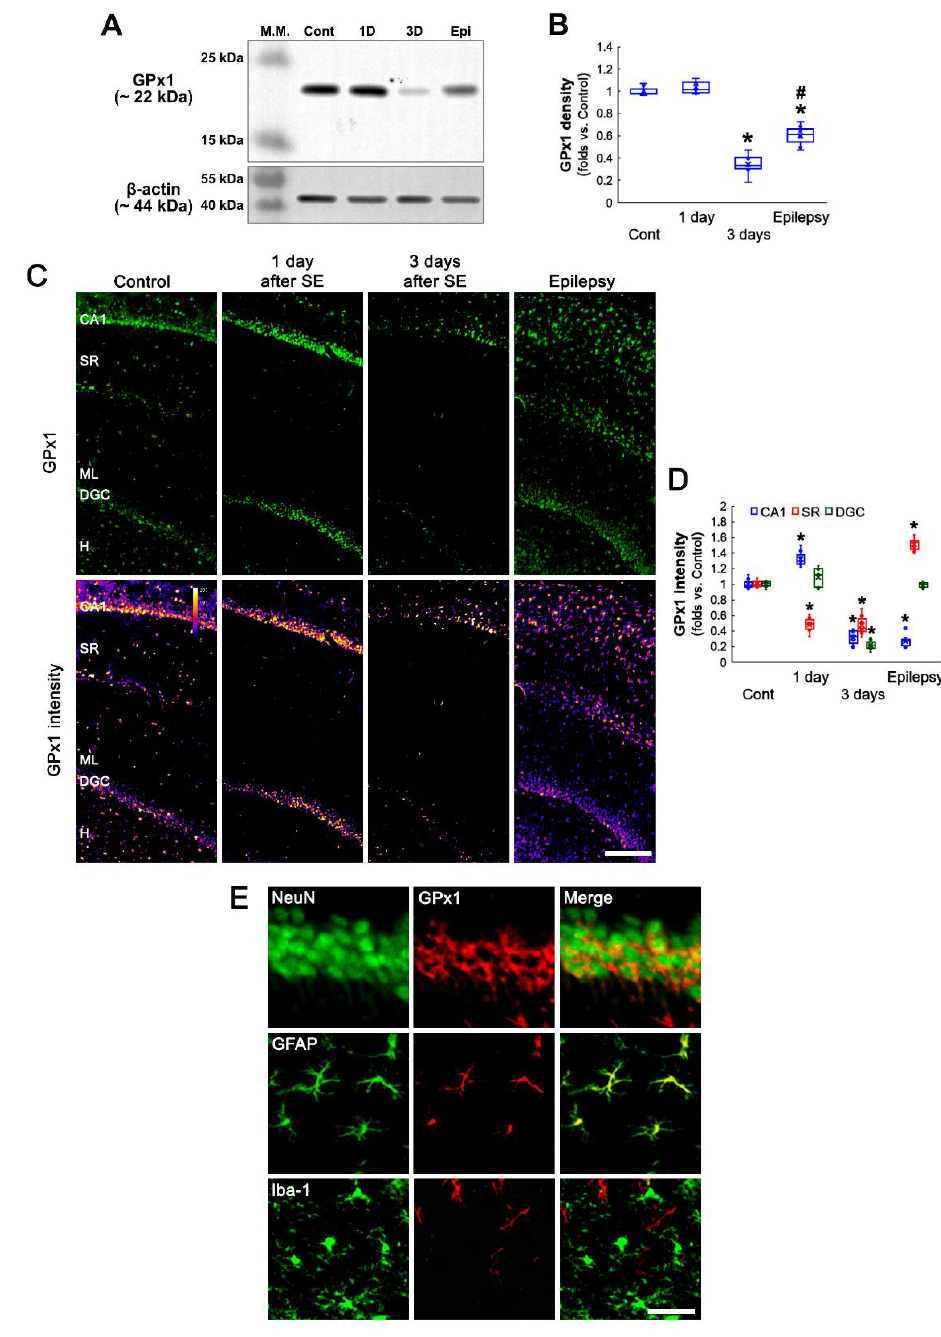
Figure 1. Effects of SE on GPx1 expression in the rat hippocampus. GPx1 expression is mainly observed in neurons (NeuN, a neuronal marker) and astrocytes (GFAP, an astroglial marker), but not microglia (Iba-1, a microglial marker), under physiological conditions. Following SE, GPx1 expression shows the temporal and spatial alterations in the hippocampus. ( A ) Representative Western blot of GPx1 in the whole hippocampus. ( B ) Quantification of GPx1 protein level based on Western blot data (*, # p < 0.05 vs. control and 3 day-post SE animals, n = 7, respectively). ( C ) Representative photos of GPx1 expression and its intensity. Bar = 250 μm. ( D ) Quantification of GPx1 intensity in CA1 neurons (CA1), the stratum radiatum (SR) and dentate granule cells (DGC) (* p < 0.05 vs. control animals, n = 7, respectively). ( E ) Cellular localization of GPx1 in the hippocampus under physiological conditions . Bar = 25 (NeuN) and 12.5 μm (GFAP and Iba -1).